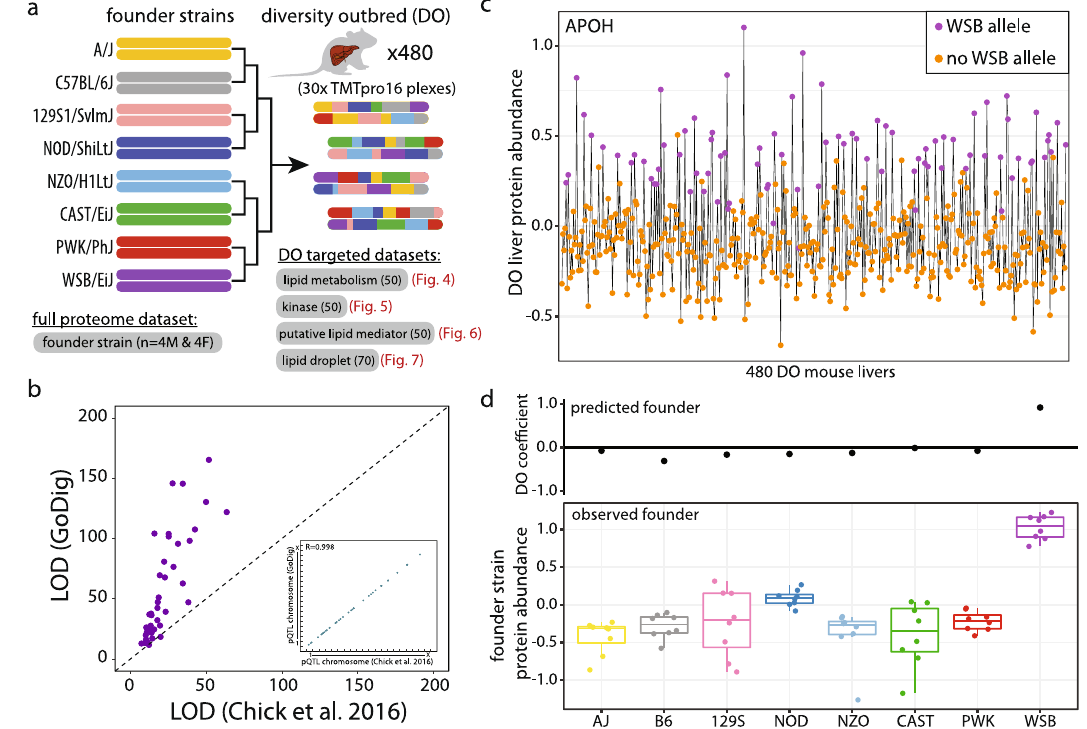
Fig. 4 | Targeted pQTL analyses of livers from 480 genotyped DO mice fed a high fat diet. a DO mouse livers were obtained from the Keller et al. study 36 and processed into thirty TMTpro16plex experiments. For GoDig analyses, four tar- geted gene lists included lipid metabolism-related proteins, kinases, putative lipid metabolismmediatorsandlipiddropletproteinsweregenerated.Inaddition,livers from 64 animalsfrom the 8 DOfounderstrains ( n =8 animals for each strain) were processedandfullproteomepro fi lingwasobtainedusingareal-timesearch(RTS)- based shotgun approach 14 . b The new LOD scores are higher using GoDig across 480 mice than the scores generated using 192 mice from Chick et al. 35 . The inset shows the great pQTL positional correlation between the re-analysis using GoDig